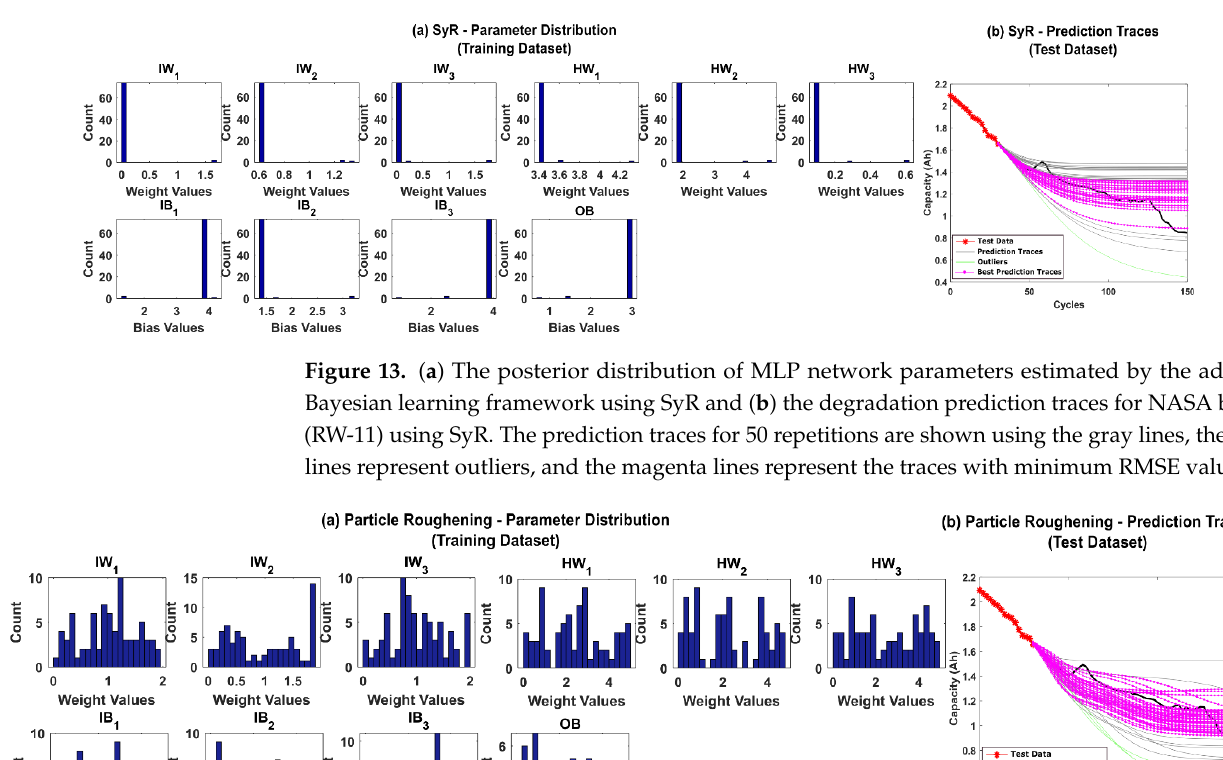
Figure 12. ( a ) The posterior distribution of MLP network parameters estimated by the adaptive Bayesian learning framework using StR and ( b ) the degradation prediction traces for NASA battery (RW-11) using StR. The prediction traces for 50 repetitions are shown using the gray lines, the green lines represent outliers, and the magenta lines represent the traces with minimum RMSE values.